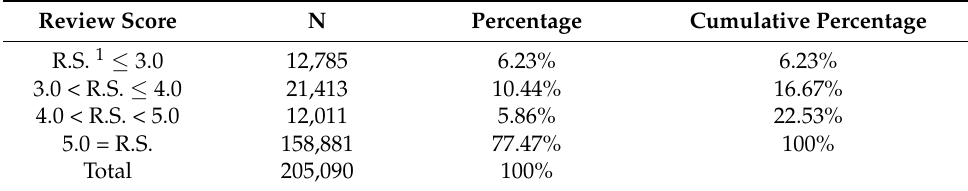
Table 3. Distribution of review scores.